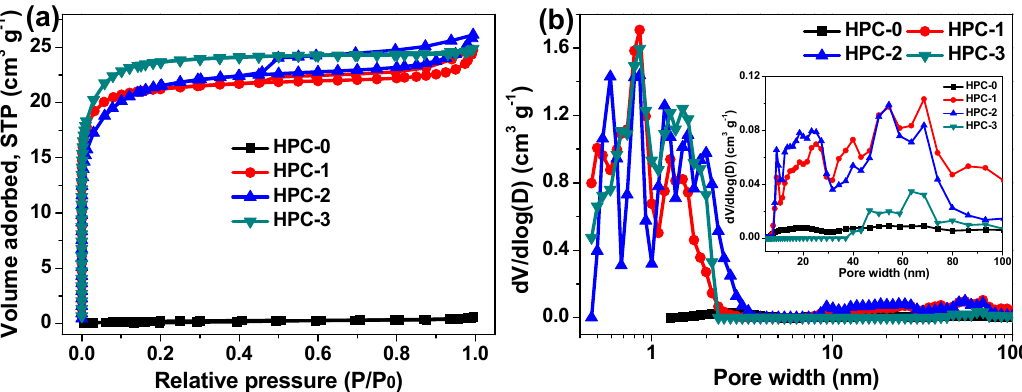
Figure 5. ( a ) N 2 adsorption/desorption isotherm curves and ( b ) Pore size distribution diagrams of HPC-0, HPC-1, HPC-2 and HPC-3. Table 1. Porosity parameters of the currently synthesized carbon materials.